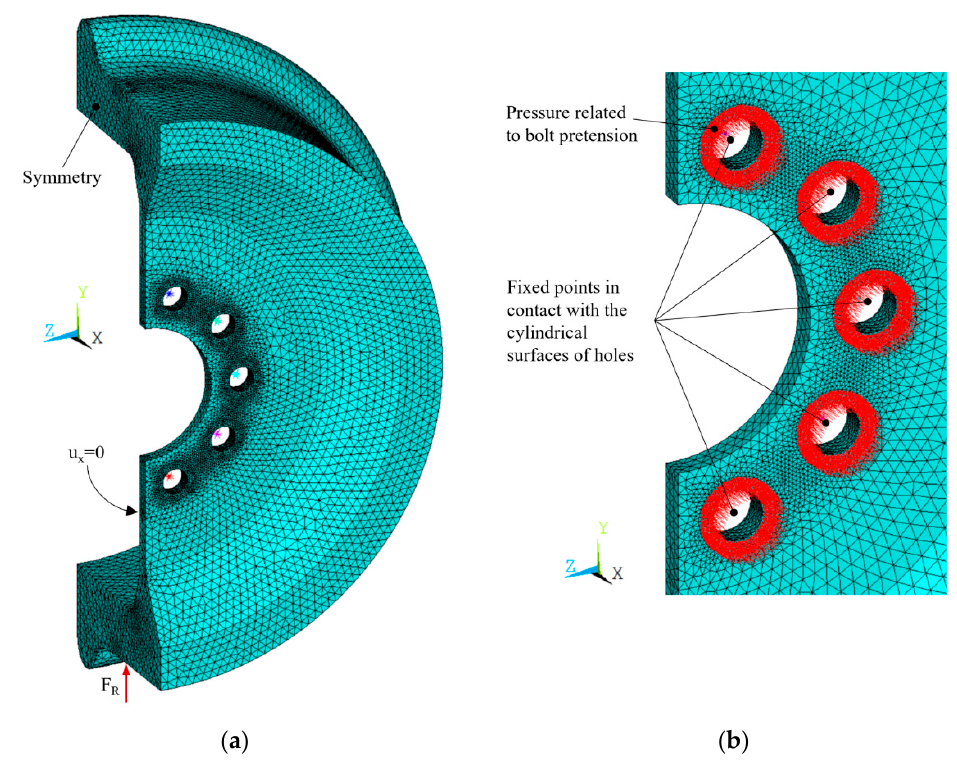
Figure 4. Finite element model of rail wheel with boundary conditions and loads. ( a ) View of the entire model; ( b ) view of bolt holes.